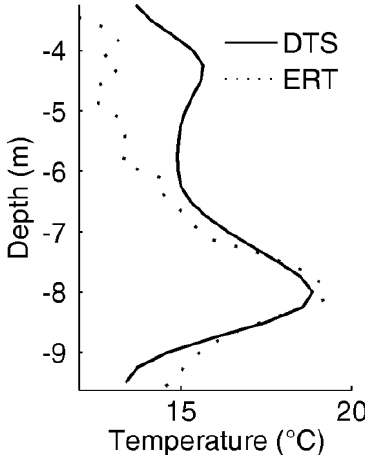
Figure 8. Comparaison of DTS and ERT-derived temperatures in borehole during heat tracing experiment (Figure 4). The agreement is very good which validates the ability of ERT. The difference in the upper part of the aquifer likely results from convection in the borehole. This effect is less important in ERT which provide a temperature on an integrated volume (modified after